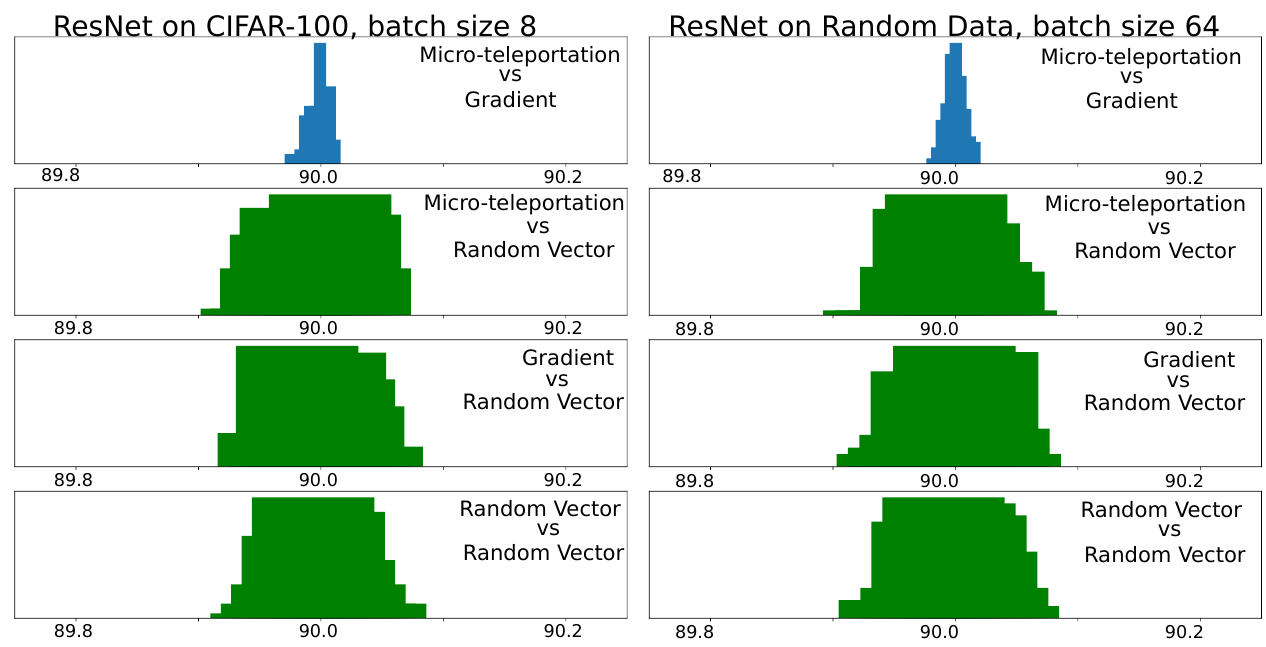
Figure A1. Micro teleportation experiments for MLP on CIFAR-100 and VGG on random data.